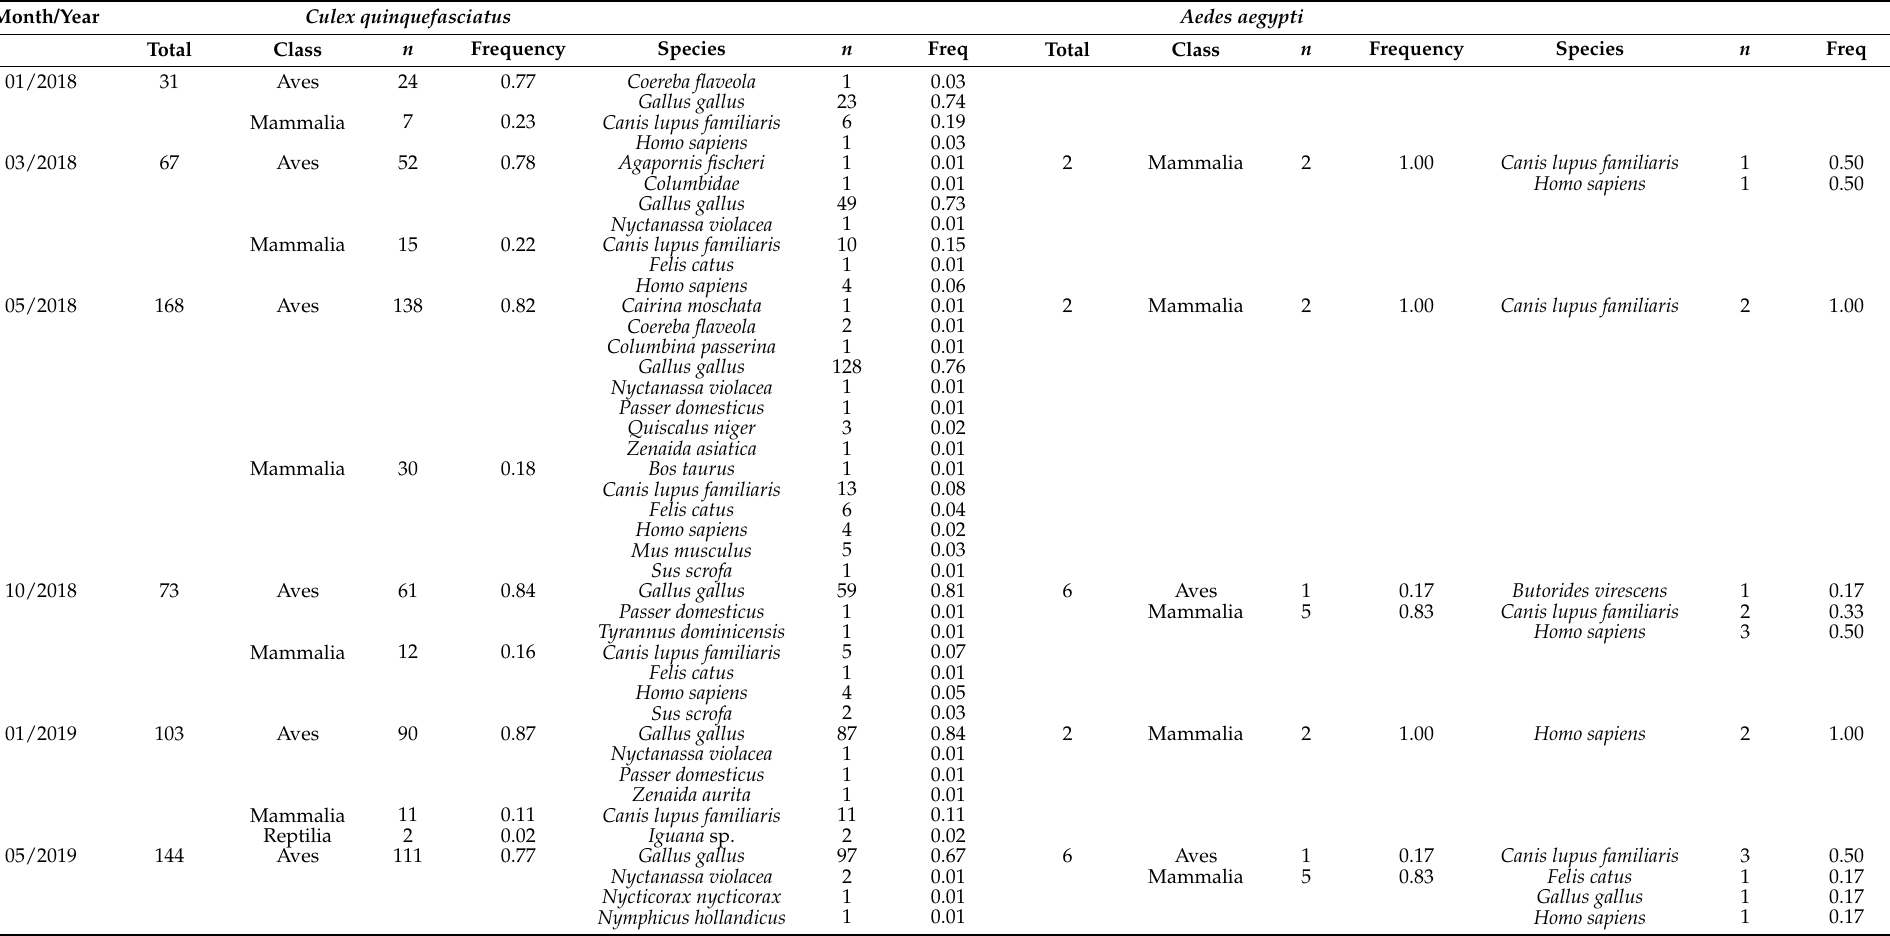
Table 3. Molecular blood meal identifications separated by trapping date. Identifications are presented for class and species. The number of times that species was detected in an individual mosquito ( n ) and frequency of identification are presented for two mosquito species collected in the San Juan Metropolitan Area, Puerto